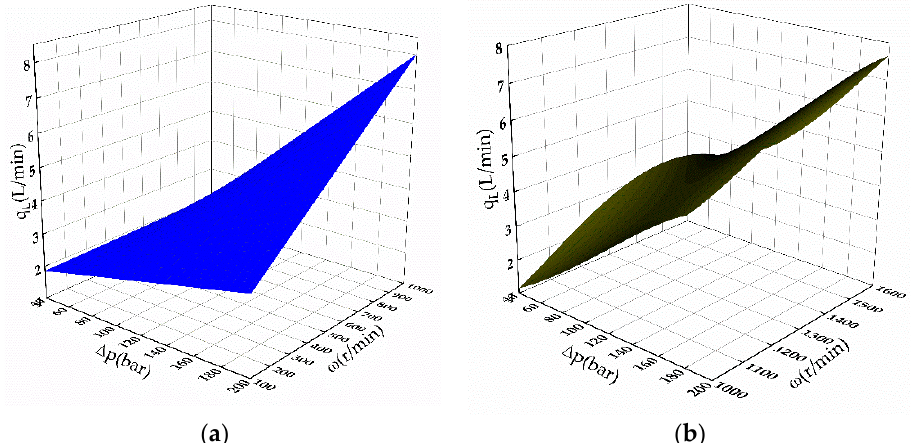
Figure 5. ( a ) Polynomial fitting curve for motor leakage estimation model with ω m < 1000 r/min, ( b ) polynomial fitting curve for motor leakage estimation model with ω m > = 1000 r/min